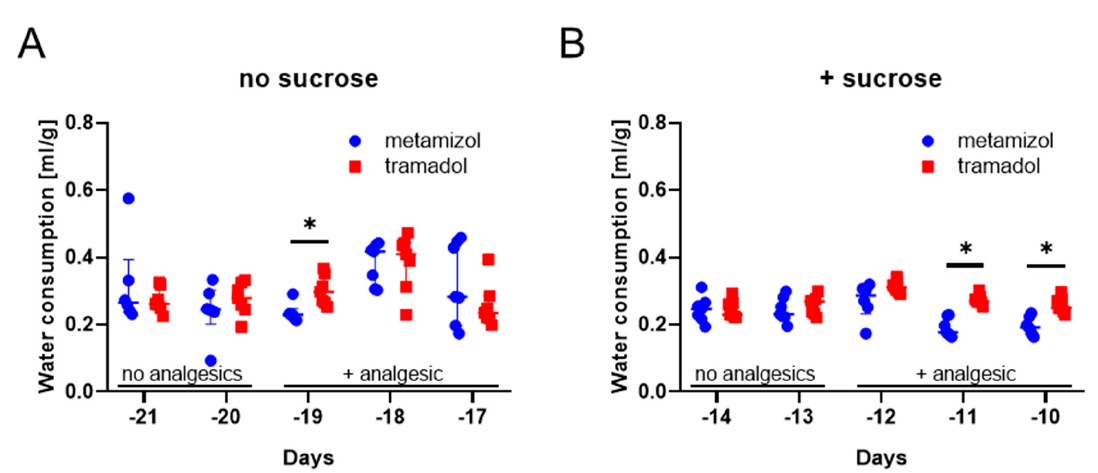
Figure 3. Impact of analgesics on water consumption during the pre-experimental phase. Water Consumption (mL) divided by body weight (g) was assessed on the days indicated, using drinking water, without ( A ) or with sucrose ( B ). * Statistically significant differences between metamizole and tramadol treatment was obtained (using two-way repeated measure ANOVA in a mixed-effect model with Sidak’s correction for multiple comparisons). Metamizole: n = 6–7 (since the water bottle for one animal leaked on day − 21, day − 20, day − 19, and day − 12, these data were not included); tramadol: n = 7.